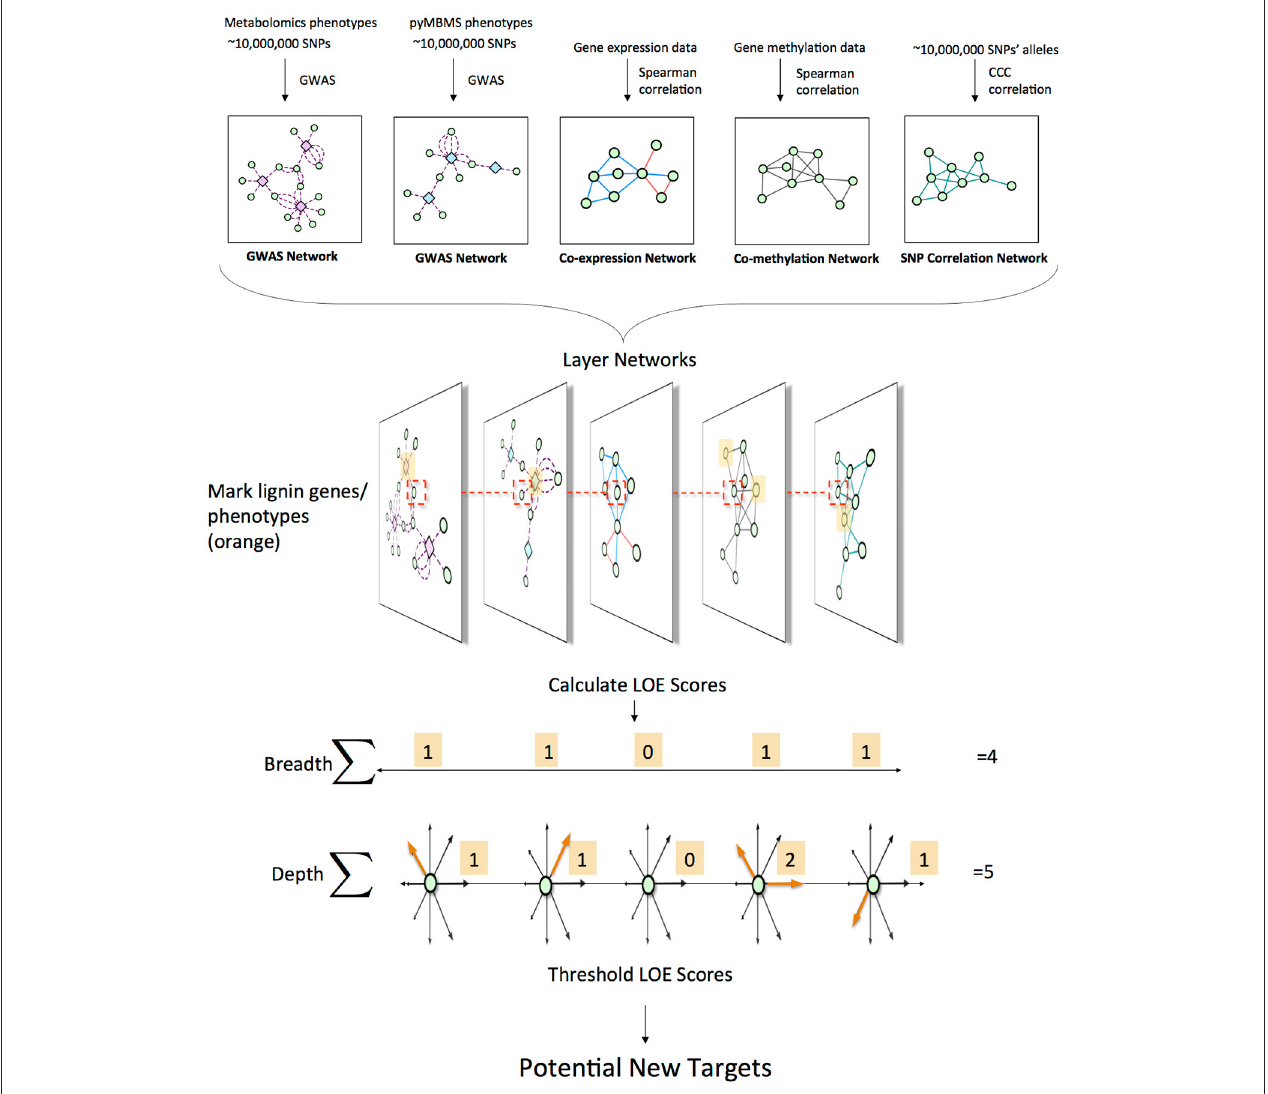
FIGURE 1 | Overview of pipeline for data layering and score calculation. First, the different network layers are constructed. Networks are layered, and lignin-related genes and phenotypes (orange) are identified. LOE scores are calculated for each gene. An example of the LOE score calculation for the red-boxed gene is shown. Thresholding the LOE scores results in a set of new potential target genes involved in lignin